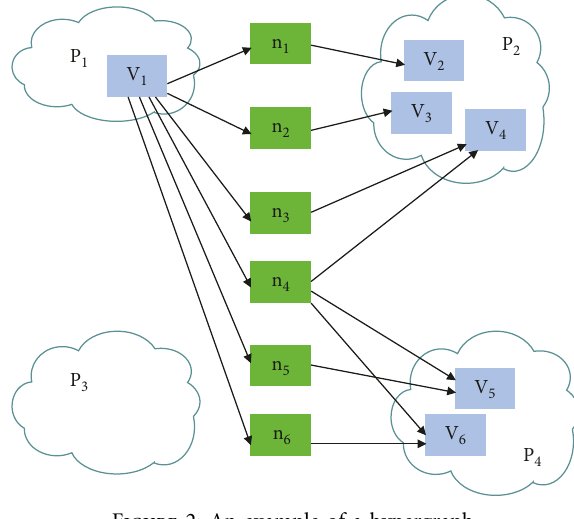
Figure 2: An example of a